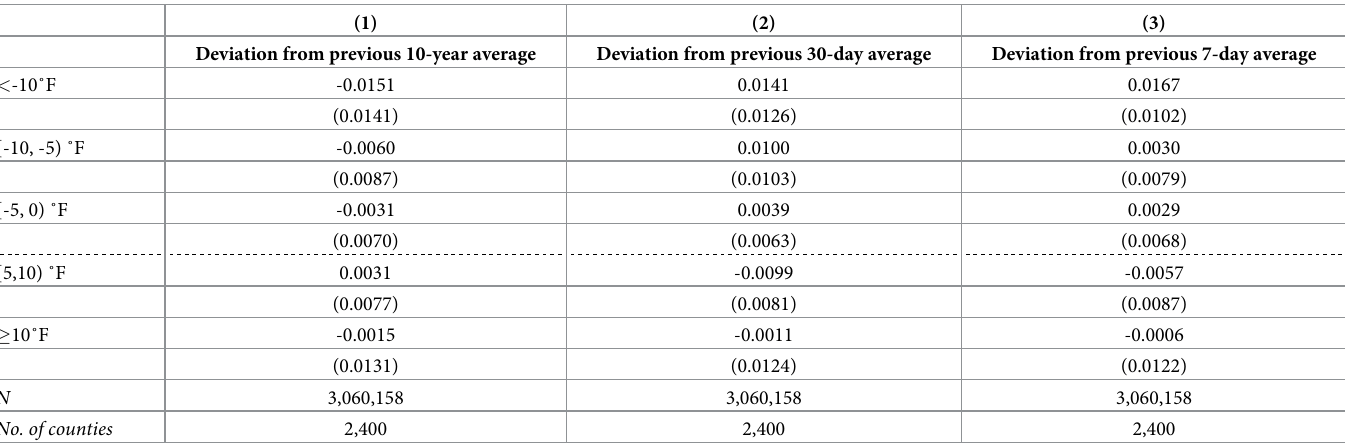
Table 4. Effect of day-of temperature deviations on the probability of self-reported mental health